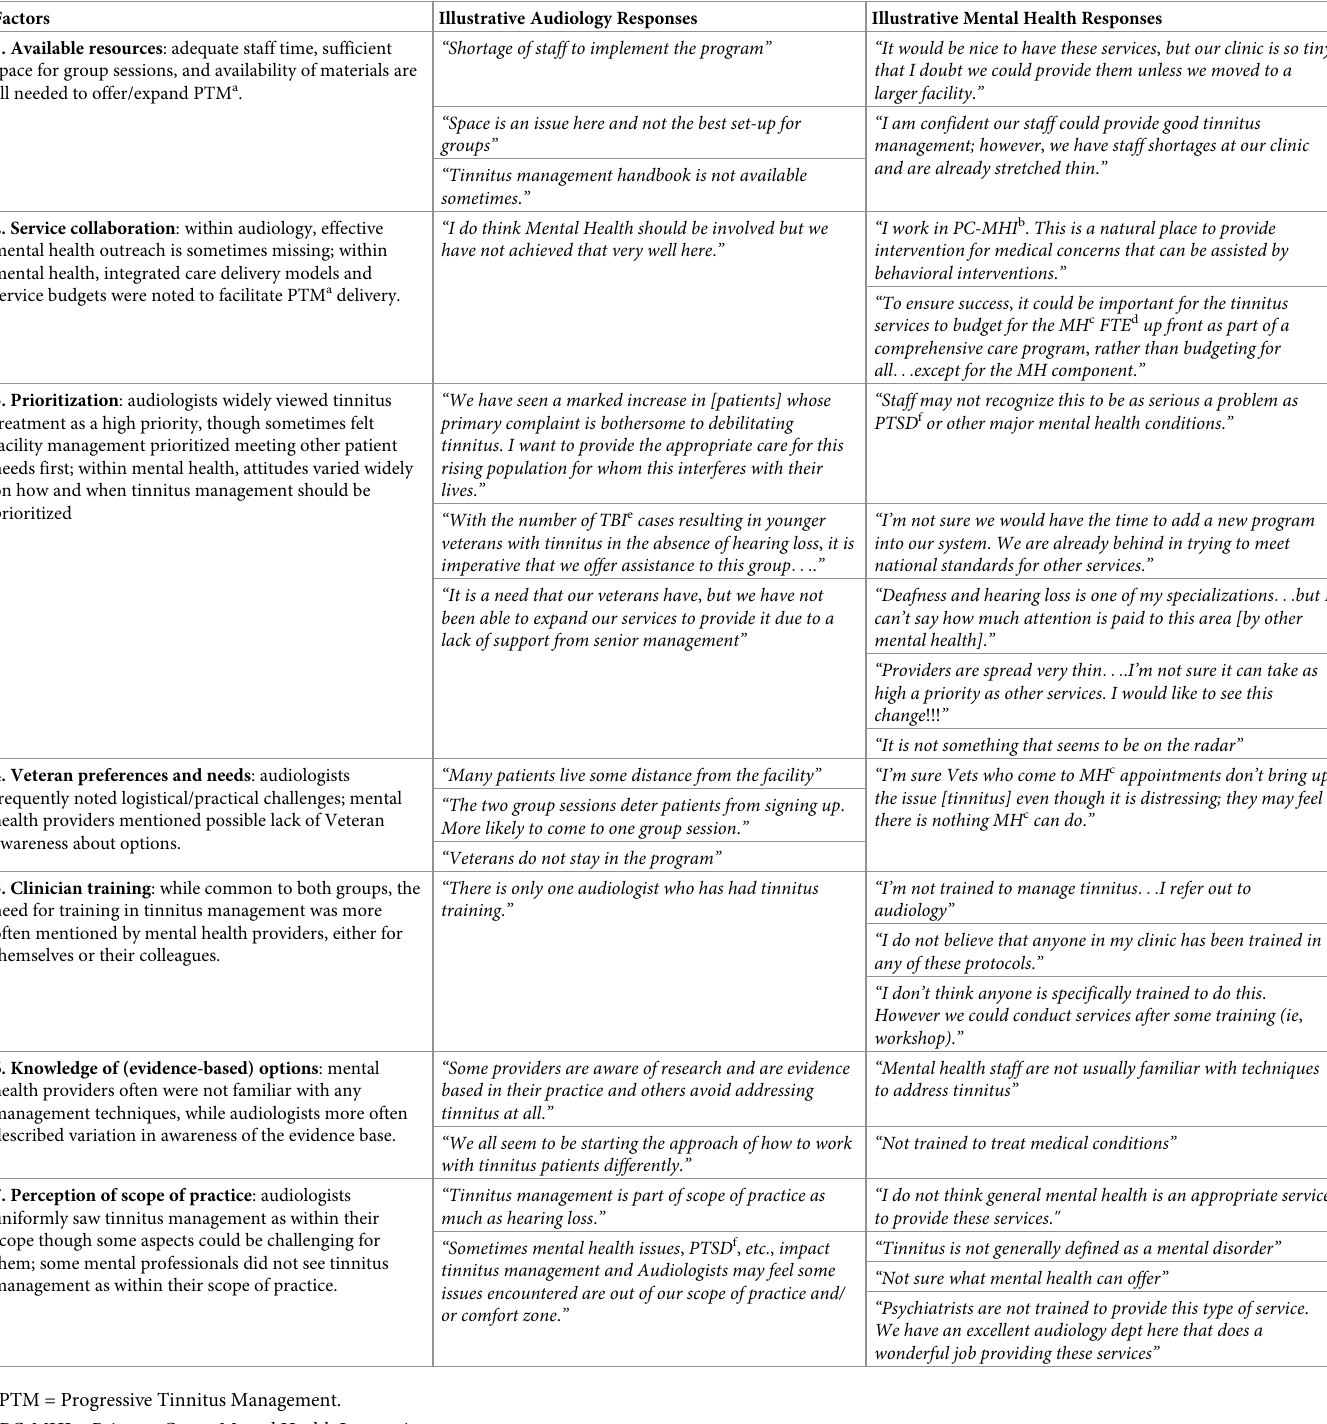
Table 5. Factors influencing implementation of Progressive Tinnitus Management